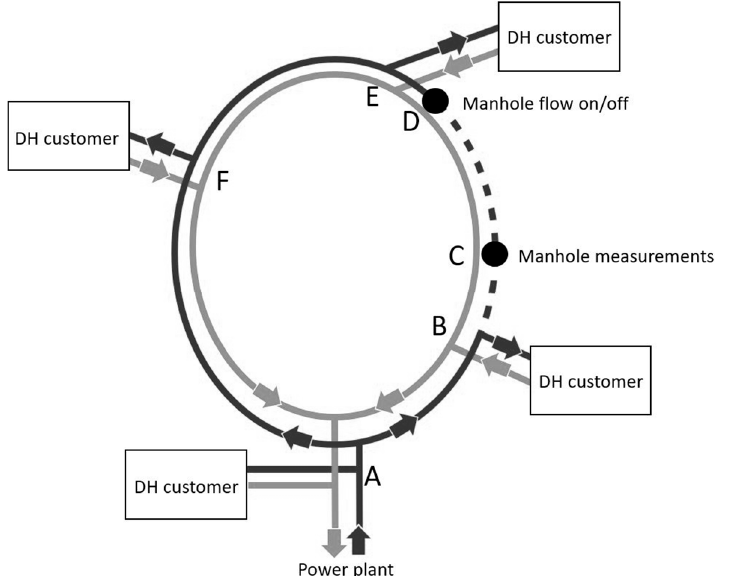
Figure 9. Pipe network and measurement location C (i.e., valves). Normal flow direction is A–E. During shutdown at valve point D, the flow between B and D (dashed line) stops. Supply water is shown in black and return water in grey.